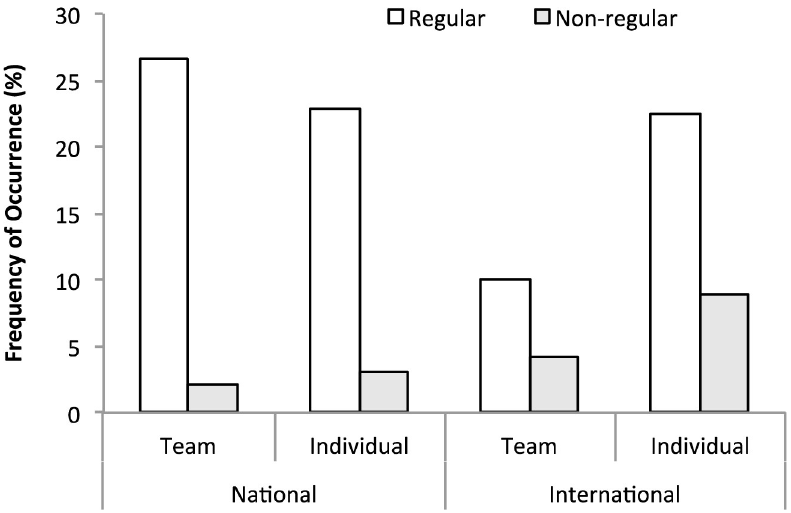
Fig 1. Frequency of occurrence (%) of regular (14–19 yr) and not-regular ( > 19 yr) high school student-athletes competing at national or international levels in individual or team sports.